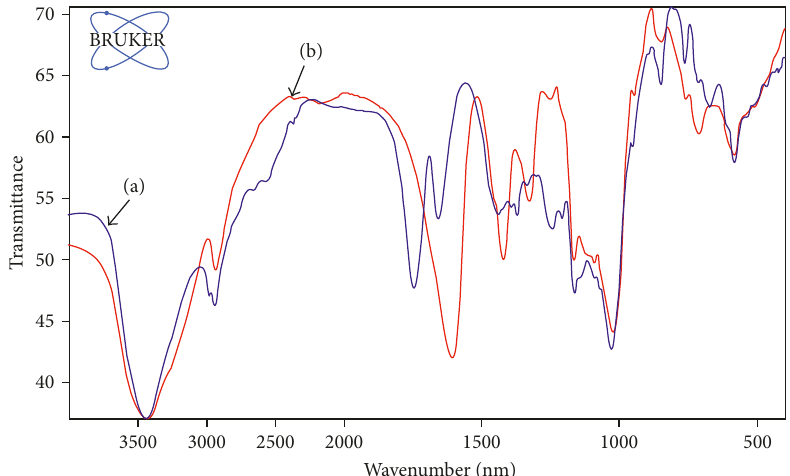
Figure 4: The absorption peaks by FTIR: (a) CDRes and (b) raw material of CM- β